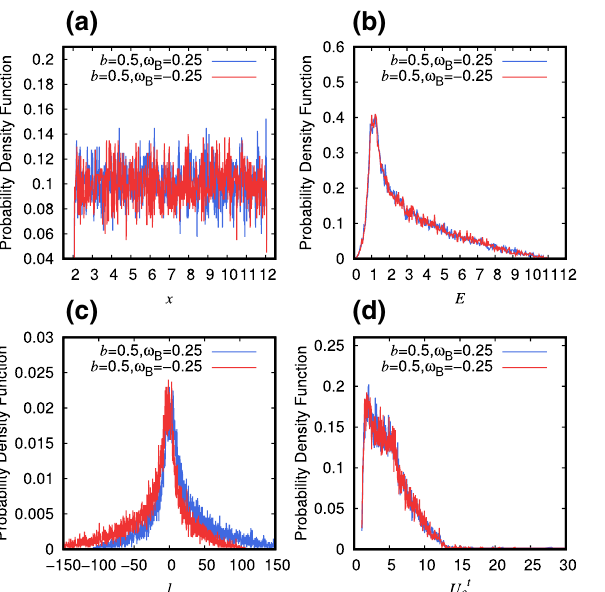
U t in quantum-corrected Schwarzschild black holes. 0